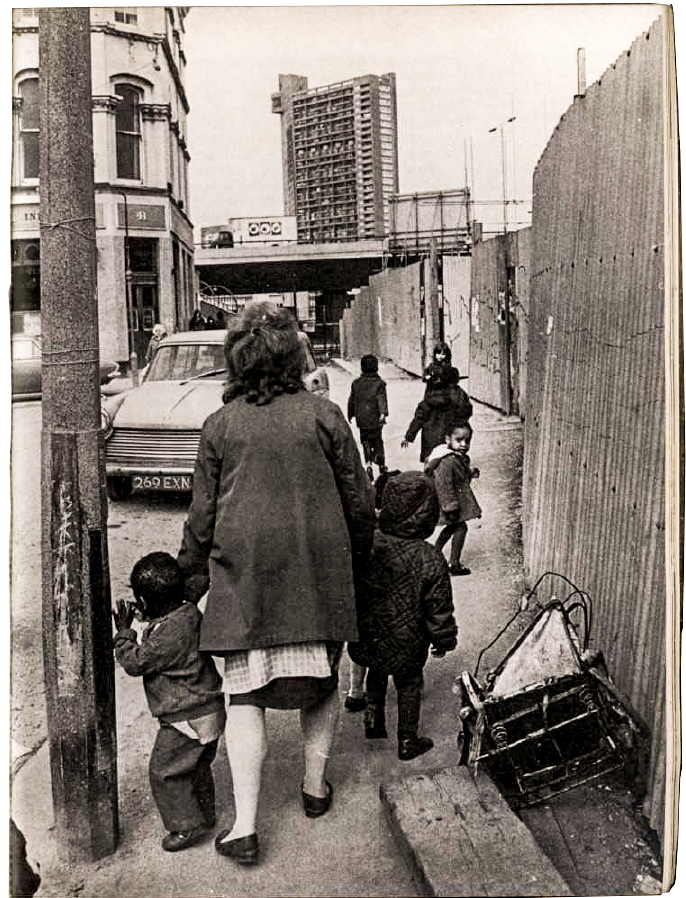
Figure 1. Illustration from Colin Ward’s The Child in the City (Ward,